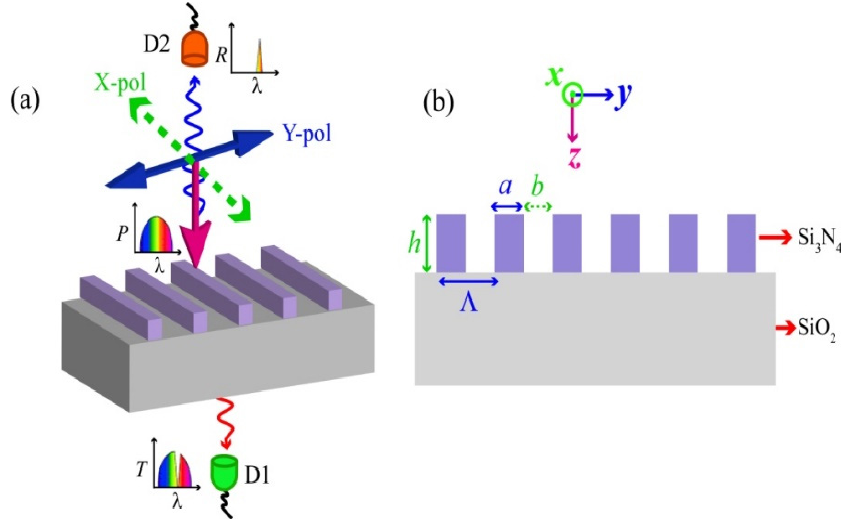
Figure 1. Si 3 N 4 grating-based BIC system ( a ) shows the schematic 3D representation of the proposed BIC structure. The incident light source is polarized in two orthogonal planes with X-pol (green) and Y-pol (blue) D1, D2, P , T , R , and λ denote detector-1, detector-2, power of light, transmittance, reflectance, and wavelength of the incident light, respectively. ( b ) Shows a 2D representation of the structure having different parameters.